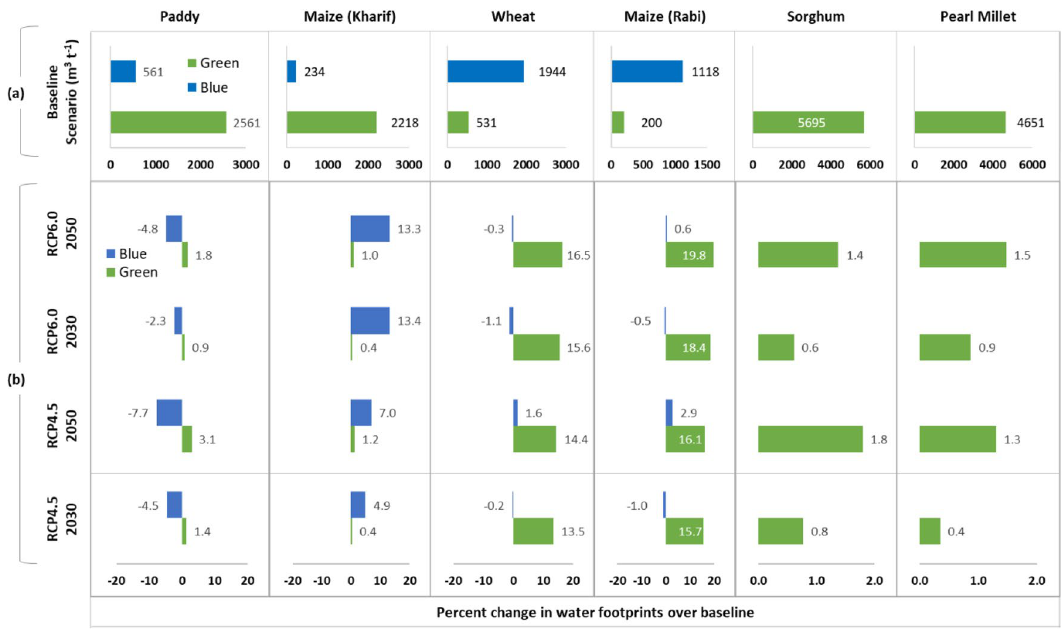
Figure 2. ( a ) Average blue and green WF (m 3 /t) under baseline scenario and ( b ) percent change in average blue and green WF of cereal crops under two projected climate change scenarios (RCP4.5 and RCP6.0) for the two time periods (2030s,